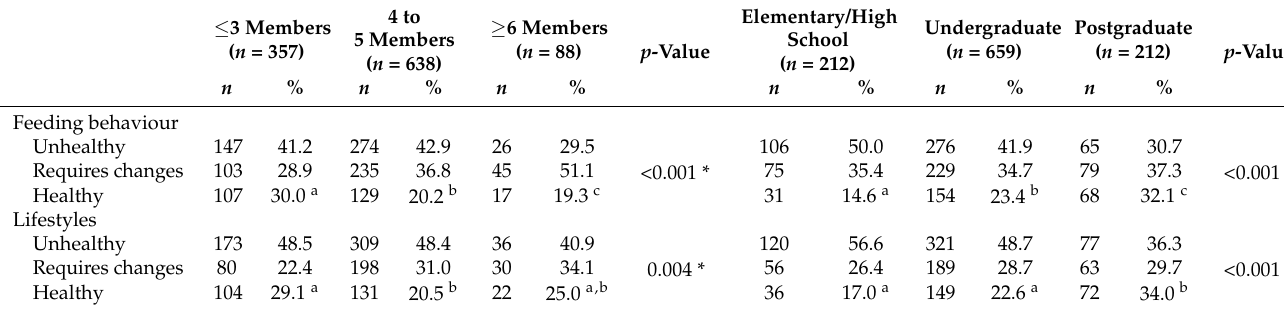
Table 4. Feeding behaviour and lifestyles of children and adolescents according to the number of members in the family group and educational level of parents and